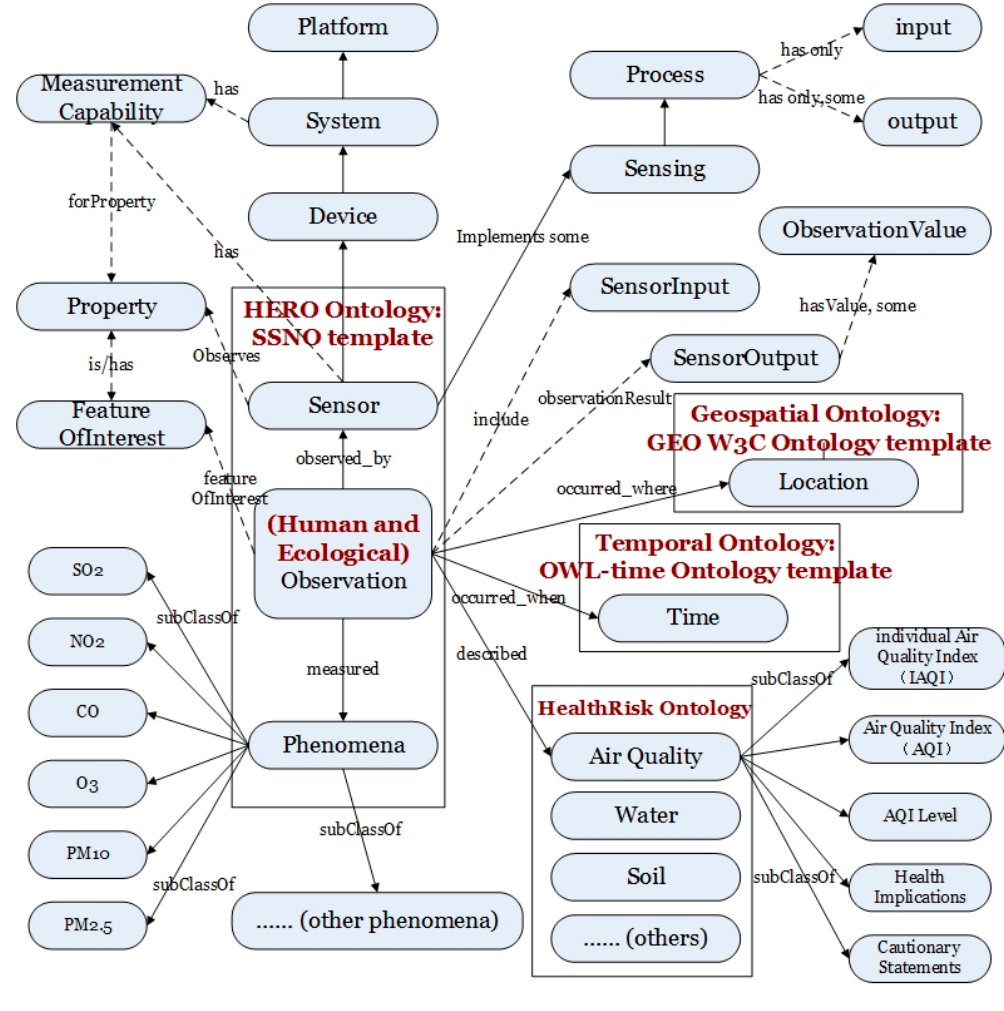
Figure 4. HERO Ontology.